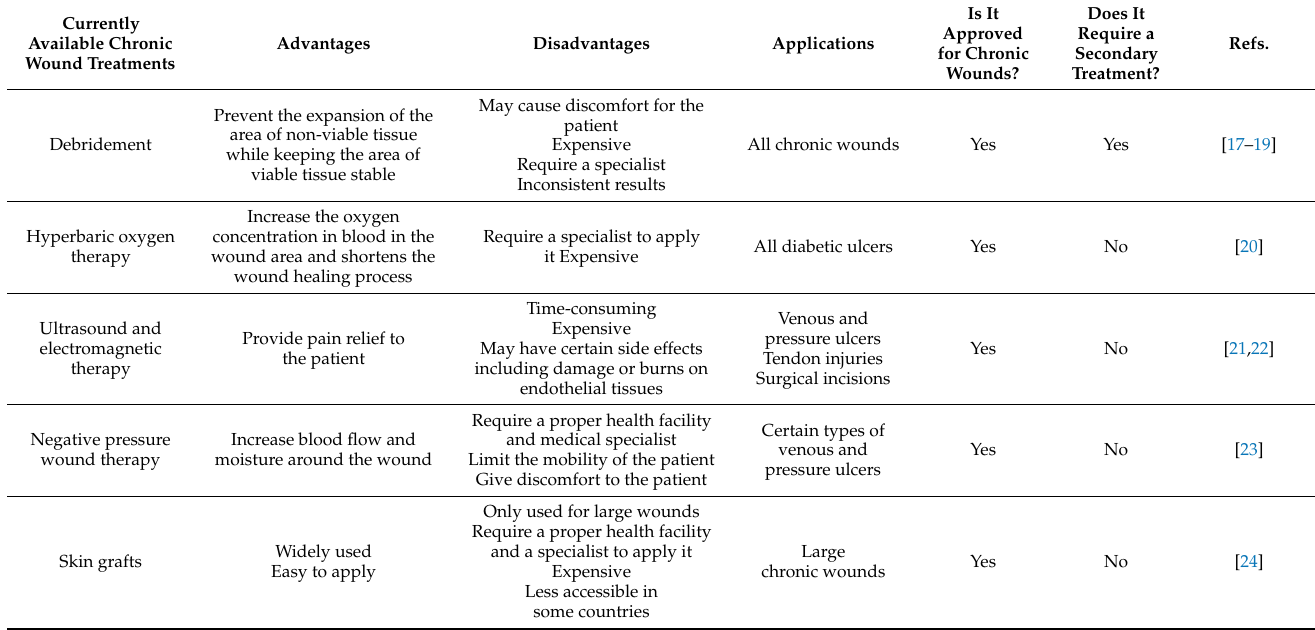
Table 2. Currently available chronic wound